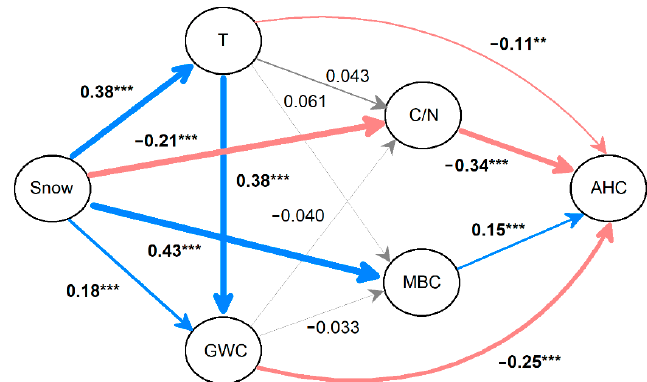
Figure 5. Path analysis shows direct and indirect effects of the variation in snow depth on the release of acid hydrolysable components. The color (blue: positive, and red: negative) and gray arrows denote significant and non-significant effects, respectively. The widths of the arrows and associated numbers (standard regression weights) represent the strength of the path coefficients, and the bold coefficients with asterisks are significant (** p < 0.01 and *** p < 0.001). T: temperature, GWC: gravimetric water content, C/N: carbon to nitrogen ratio, MBC: microbial biomass carbon, and AHC: acid hydrolysable components. n = 576, R 2 = 0.531, p < 0.001 for the model.